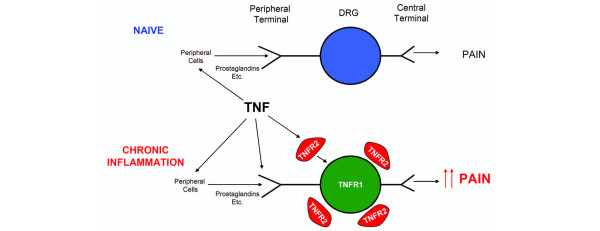
Actions of tumour necrosis factor (TNF) on hyperalgesia in health and in chronic inflammation. In the naive dorsal root ganglion (DRG), TNFα acts on peripheral cells to induce a proinflammatory cascade resulting in the release of mediators, such as prostaglandins, that activate nociceptive neurons, resulting in pain. After chronic inflammation, tumour necrosis factor receptor type 1(TNFR1) is up-regulated on DRG neurons, while TNFR2 is expressed by infiltrating macrophages. TNF can directly modulate neuronal function and act on peripheral cells and DRG macrophages to induce inflammatory mediators that can modulate neuronal function. This results in exaggerated pain.